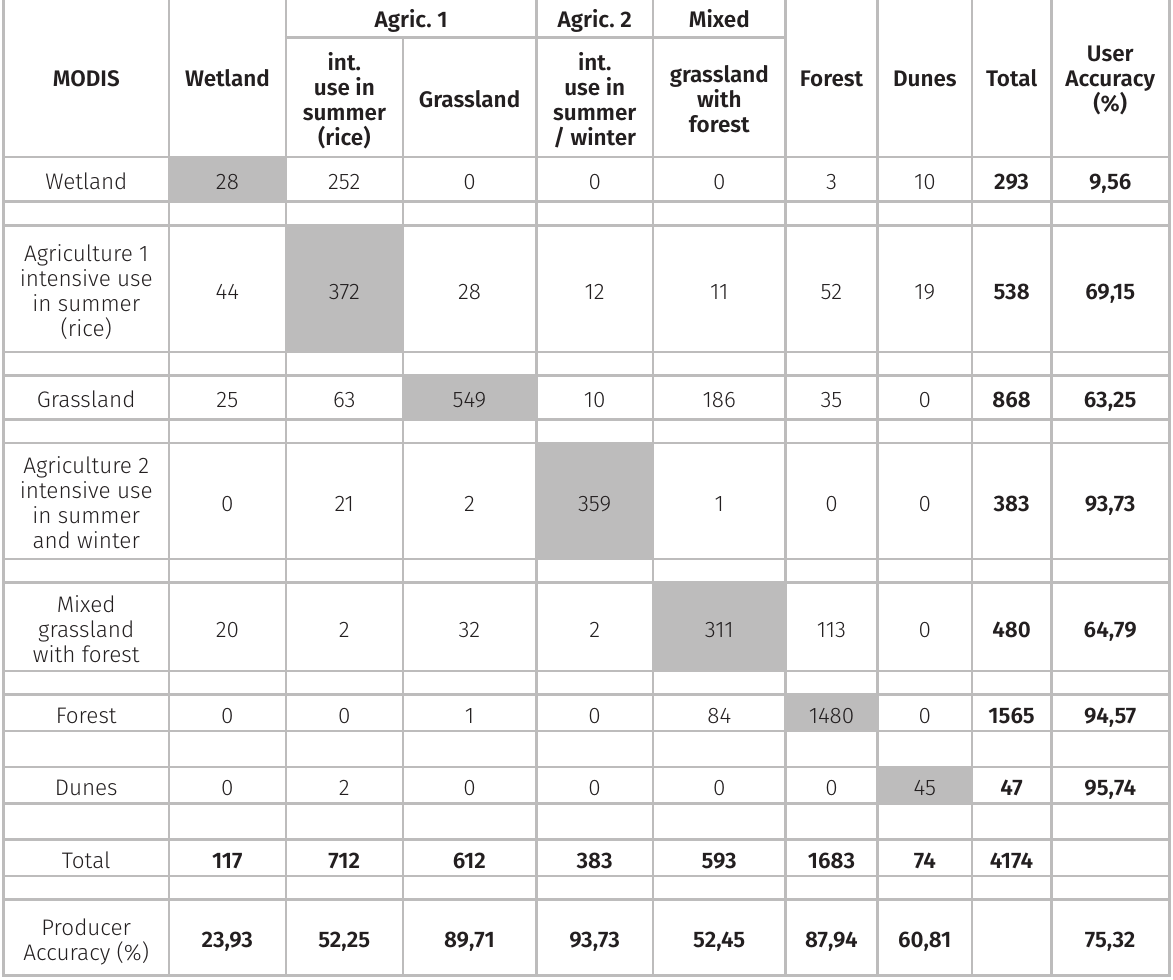
Table I. Confusion matrix resulting from the comparison between the MODIS classification and reference map, for each homogeneous region of vegetation cover in Rio Grande do Sul -